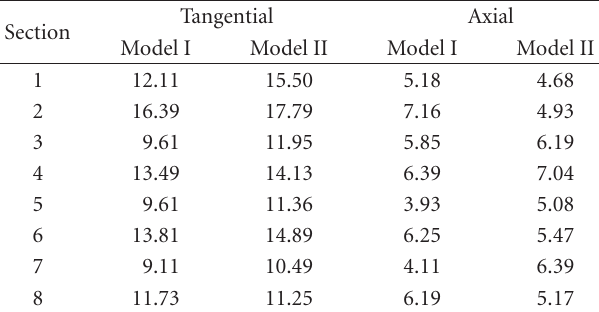
Figure 9: Final grid generation for three-dimensional full deck model. Table 3: Maximum tangential and axial velocity (m/s) ( H 2 /H 1 = 0 . 577).